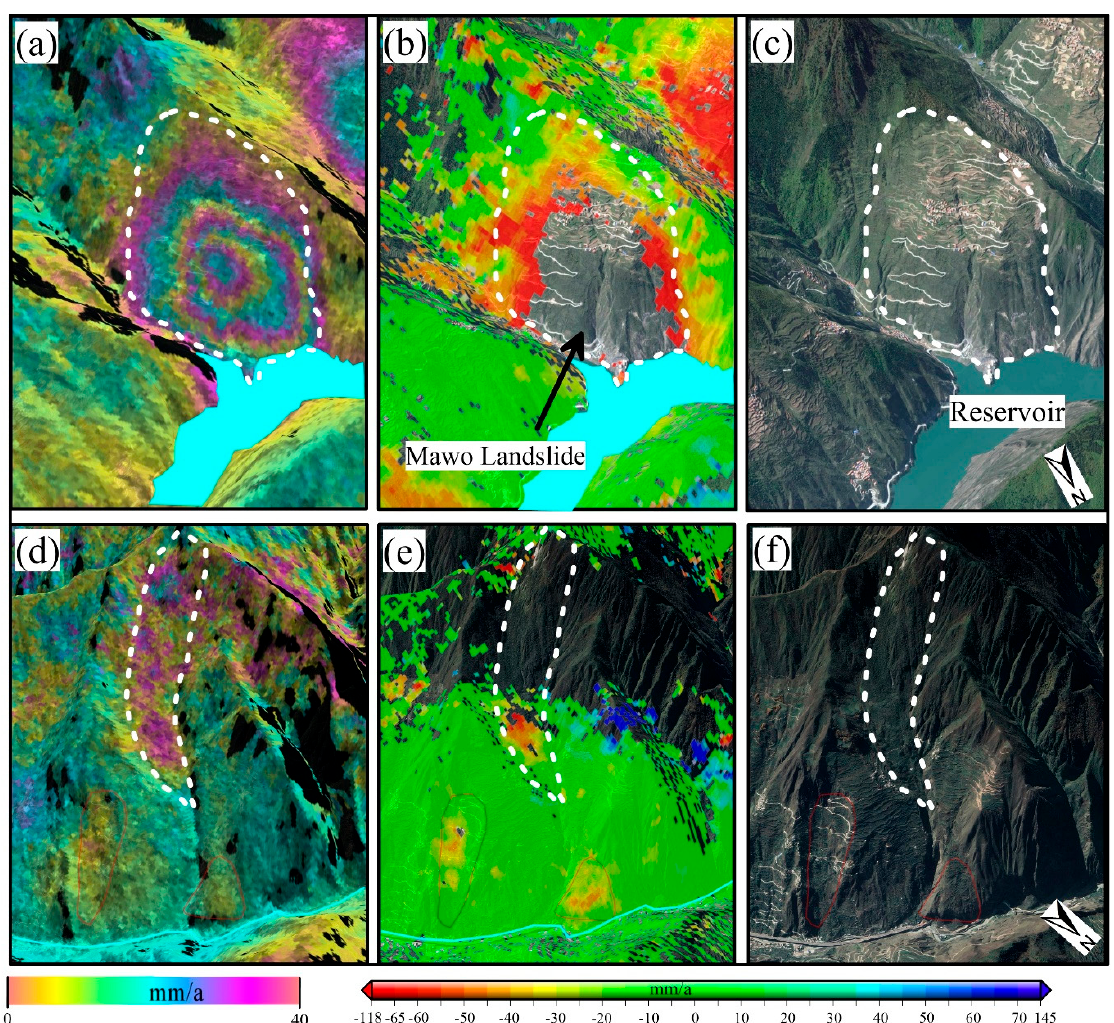
Figure 7. The potential landslides that can only be identified by Stacking-InSAR method. ( a , d ) Stacking-InSAR results; ( b , e ) SBAS-InSAR result; ( c , f ) Google Earth optical image.